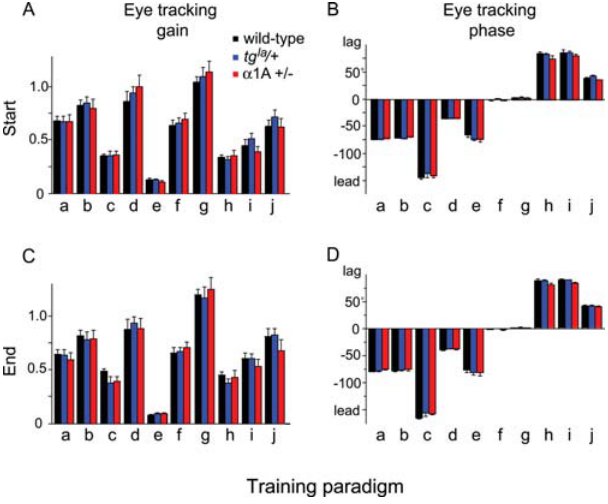
Figure 3. The gain (A, C) and phase (B, D) of the tracking eye movements relative to head movement made in the presence of each visual-vestibular training stimulus at the start (A, B) and end (C, D) of training. Letters correspond to the 1 Hz training paradigms described in Table 1. The tracking eye movements of the heterozygous leaner (blue) and hemizygous a 1A mice (red) during training were not significantly different from wild-type mice (black).